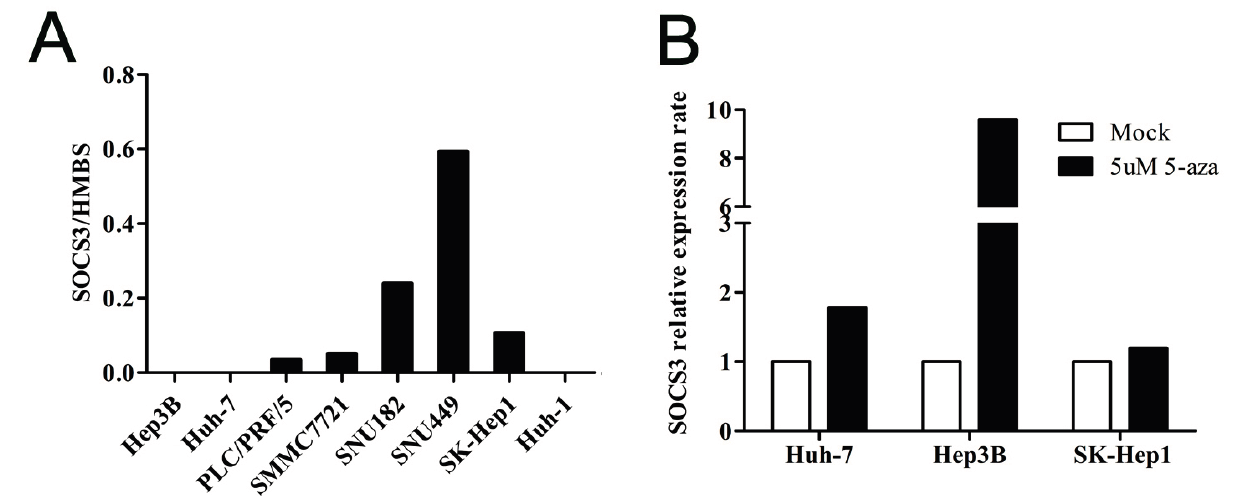
Figure 2. The mRNA expression of SOCS3 in HCC cell lines. ( A ) The mRNA expression levels of SOCS3 in eight cell lines; and ( B ) the normalized mRNA expression levels of SOCS3 in cell lines Huh-7, Hep3B, and SK-Hep1 after treatment with 5-Aza-2 ʹ -deoxycytidine for three